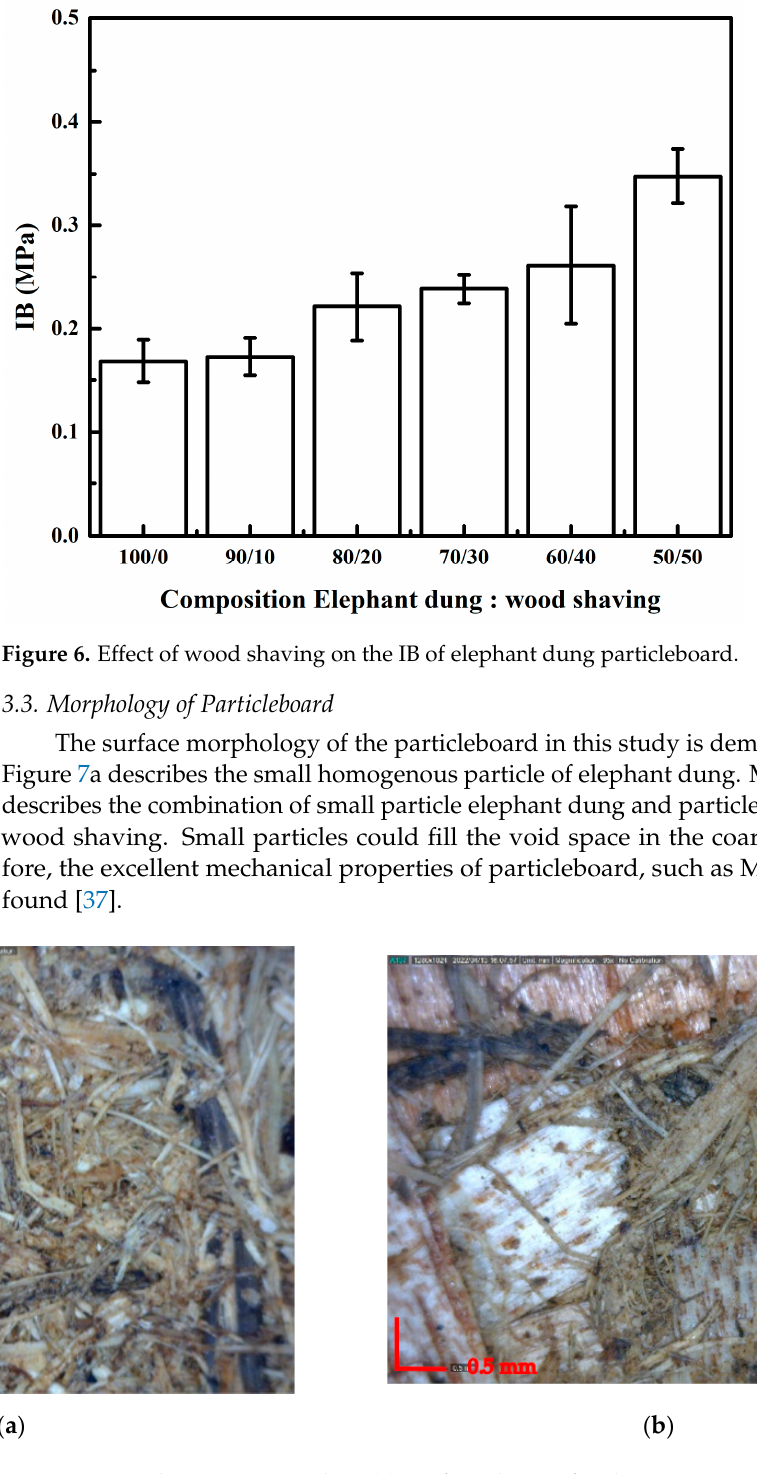
Figure 7. Digital Microscope analysis ( a ) 100/0 and ( b ) 50/50 the mixture ratio of elephant dung and wood shavings at magnification 50×.